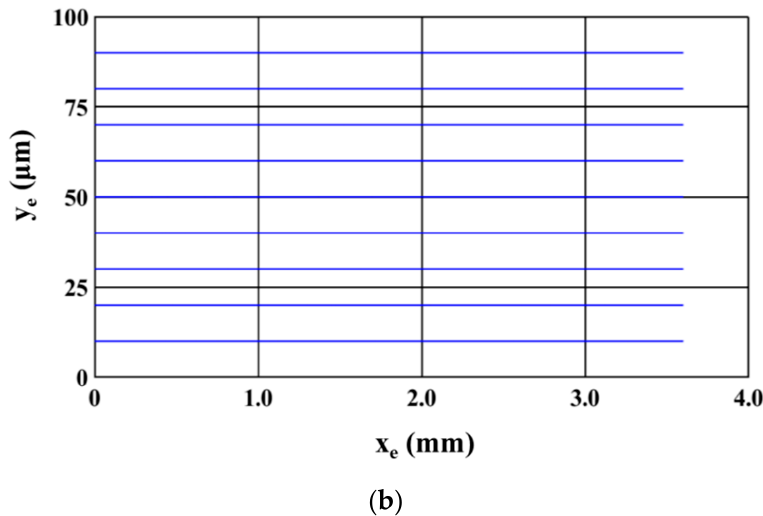
Figure 4. Top view of trajectory of microparticles ( a ) 2.5 μ m and ( b ) 5 μ m ( V 1 = 20 V pp , V 2 = 12.5 V pp , Q m = 200 μ L/h, l = 120 μ m, d = 30 μ m, n = 30, N = N cr,5 = 192.8 kHz).